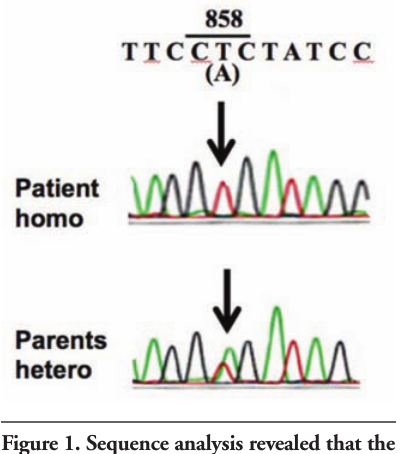
Figure 1. Sequence analysis revealed that the patient had the homozygous mutation CTC- >CAC at codon 858 (L858H) in the alleles encoding the SLC12A3 gene. Both parents were heterozygous for this